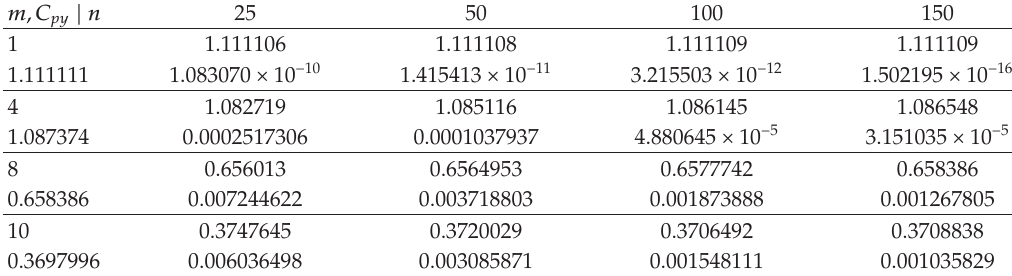
(cid:7) 0, U (cid:7) 8, samples generated from exponential